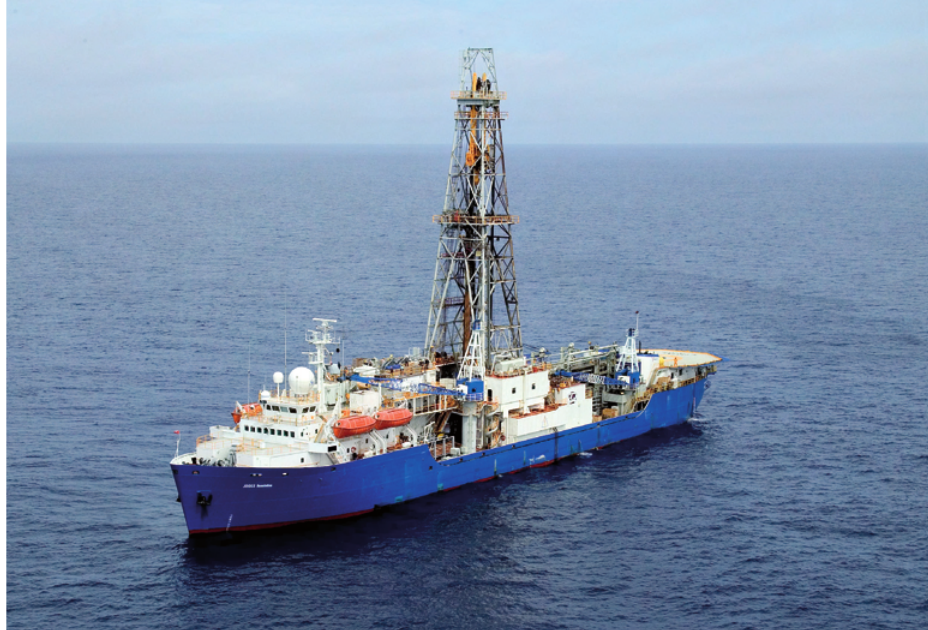
Figure 1. The pre-modernized JOIDES Resolution , an ~143-m-long, dynamically positioned drill ship, with a derrick extending >61 m above the water line, began operations in 1978 as the SEDCO/BP 471 and was converted in 1985 for use by the Ocean Drilling Program (ODP). The derrick height and overall size allow this vessel to be able to access a wide variety of ports, including passing under the Bridge of the Americas (Panama) and the Golden Gate Bridge (San Francisco, California). The name came from the JOIDES (Joint Oceanographic Institutions for Deep Earth Sampling) advisory structure and after the HMS Resolution , the vessel of exploration commanded by Captain James Cook. By the end of ODP and during initial IODP operations, the JOIDES Resolution ( JR ) included a fully equipped lab stack, the scientific heart of expeditions, equivalent in its fitting and capabilities to shore-based research